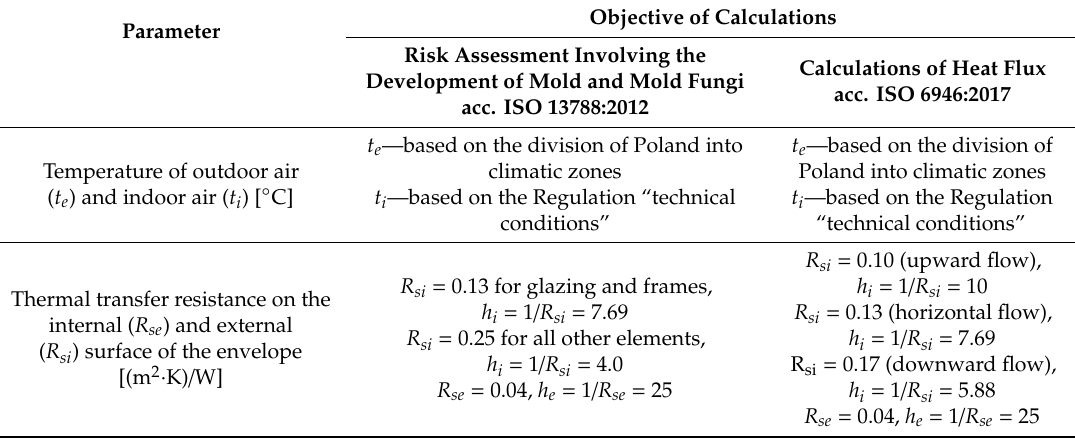
Table 7. Determination of boundary conditions for the calculation of thermal bridges—own study based on ISO 6946 and ISO